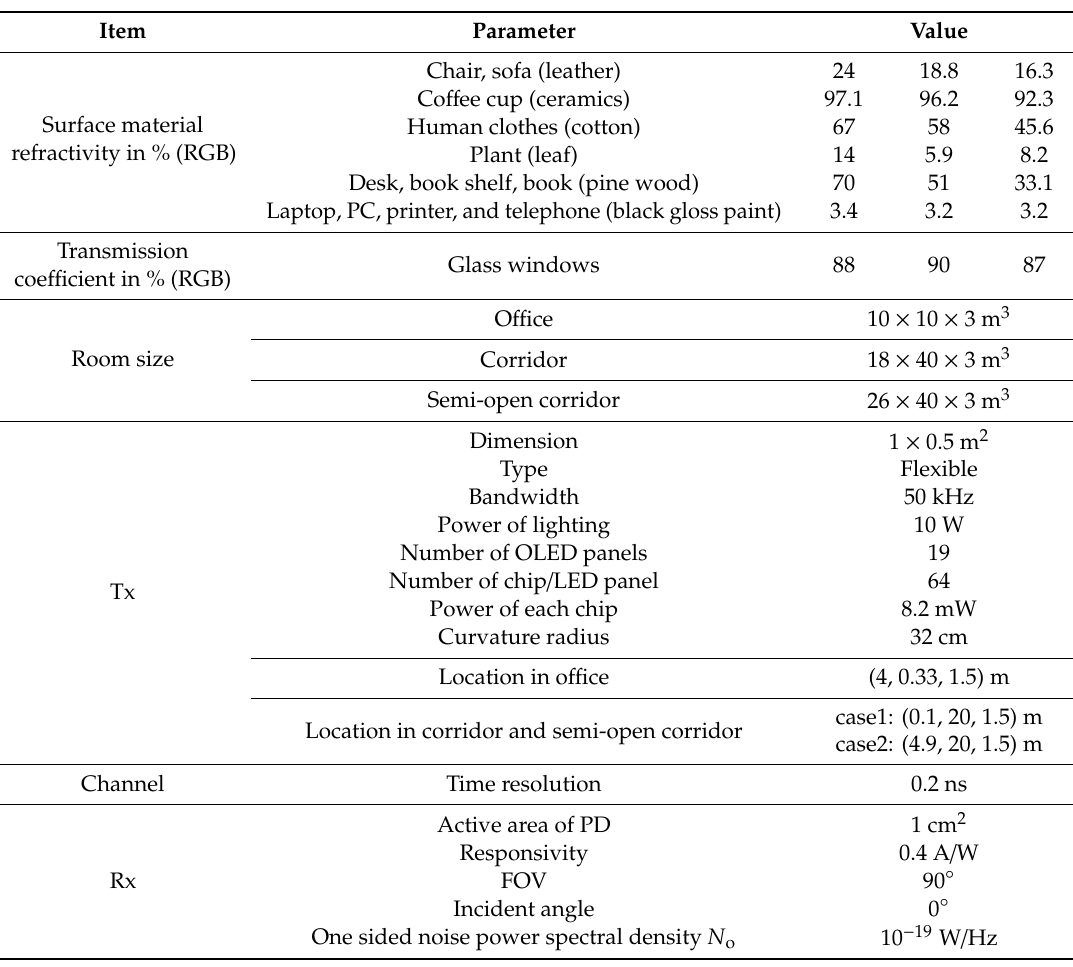
Table 1. The system